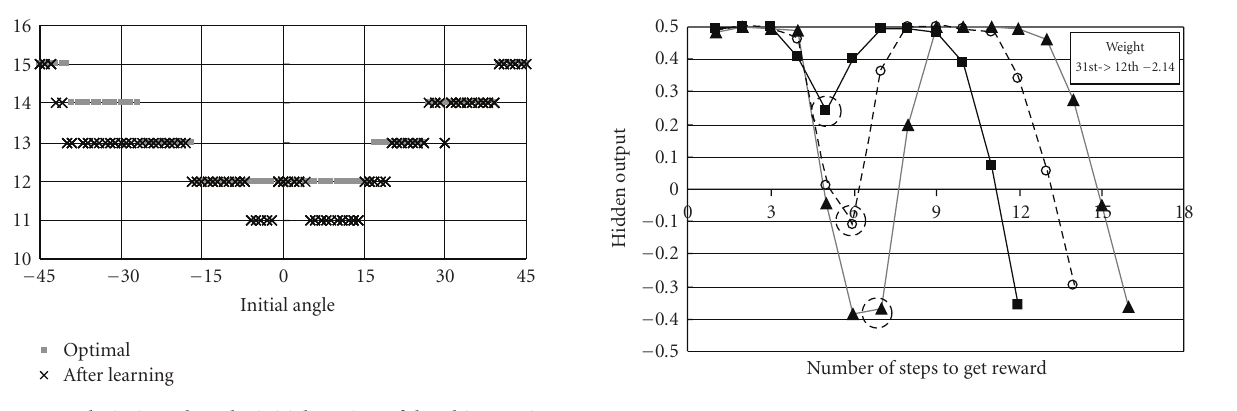
Figure 9: Catch timing when the initial motion of the object varies. The optimal catch timing is also plotted.